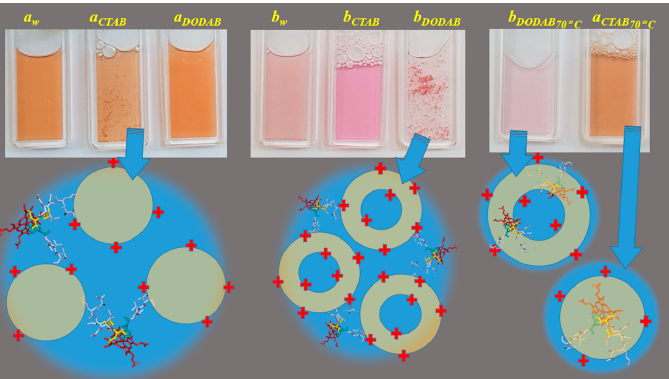
Figure 2. Snapshot of MP-11 solutions in homogeneous and heterogeneous media. Left and center panels show, respectively solutions of Fe(III) and Cu(II)MP-11. In each panel, each cuvette shows, respectively, MP-11 in HEPES-buffered aqueous solution, CTAB micelles, and DODAB liposomes at room temperature. Right panel shows, from left to right, the cuvettes containing, respectively Cu(II)MP-11 in DODAB and Fe(III)MP-11 in CTAB, after heating at 70 °C. The heating solubilized the aggregates that were shown in the left and center panels. Below the snapshots of cuvettes, the drawings represent possible MP-11/lipid structure interactions that are present in the flocculated systems at room temperature and the solubilized systems after heating. The drawings are not in scale.